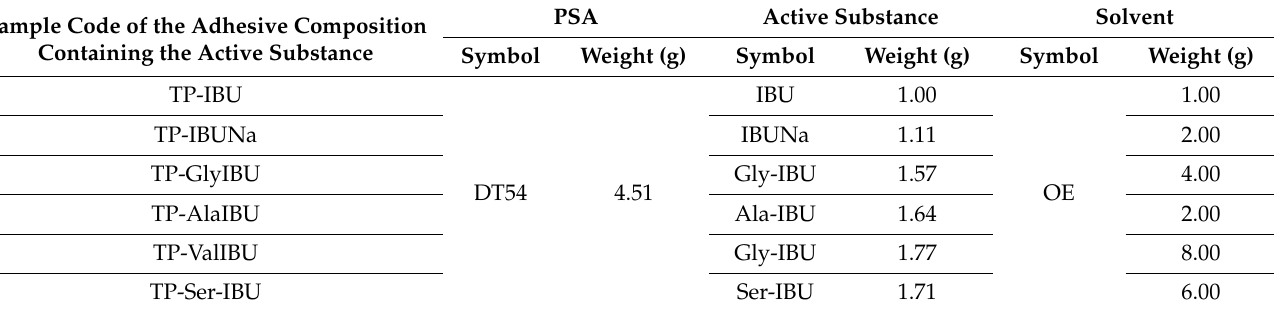
Table 8. Adhesive compositions for the preparation of transdermal